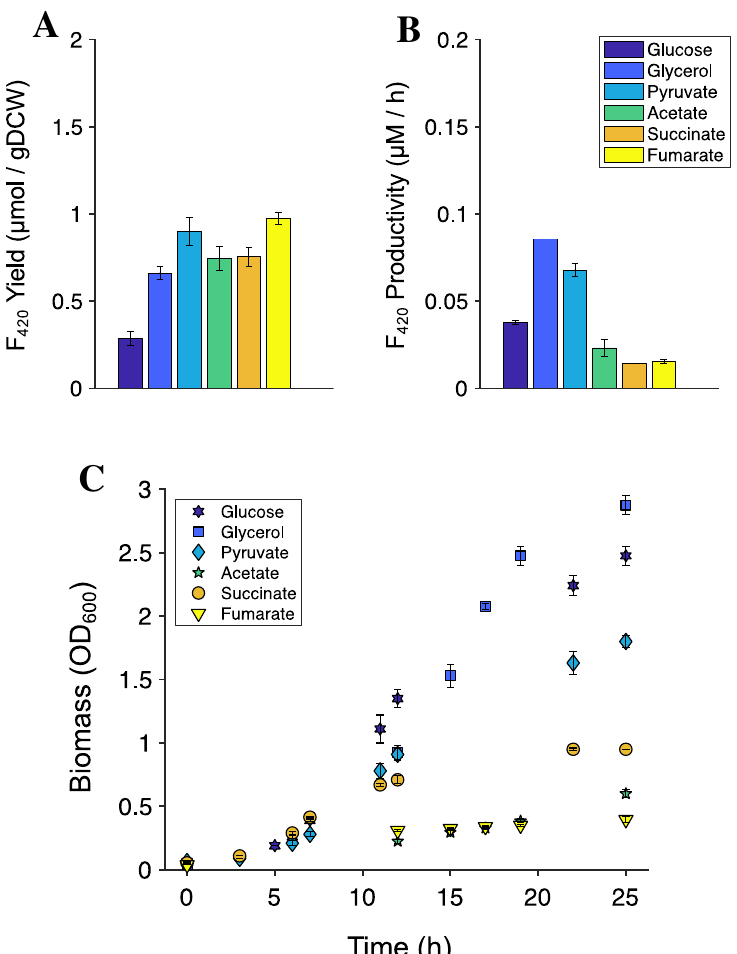
Figure 2. Cofactor F 420 production and growth of E. coli expressing phospho-enol pyruvate-dependent F 420 biosynthesis pathway using different carbon sources. ( A ) F 420 yield (in µmol per grams of dry cell weight) at the end of exponential phase of E. coli growth. ( B ) Productivity of F 420 (in µmol per liter per hour). ( C ) Growth of F 420 -producing E. coli (measured as optical density at 600 nm) over time. E. coli was cultivated in minimal media at 30 °C in shake flasks with different sole carbon sources. Error bars show standard errors of the mean of at least two